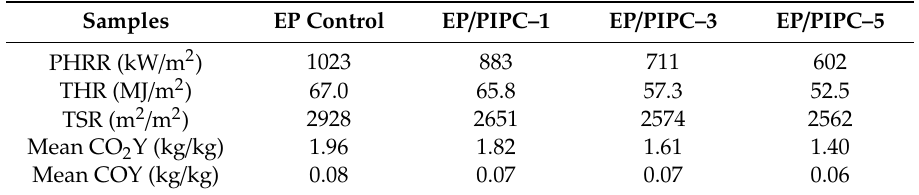
Figure 6. ( a ) Heat release rate (HRR); ( b ) total heat release (THR); ( c ) total smoke release (TSR); ( d ) CO 2 production release rate (CO 2 PR) curves; ( e ) CO production release rate (COPR) curves of the EP control and EP / PIPC composites. Table 3. Cone analysis data of EP control and EP / PIPC